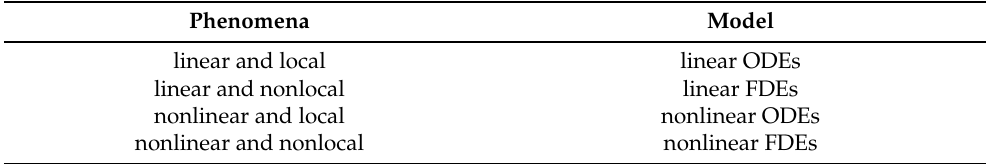
Table 1. Phenomena and model type